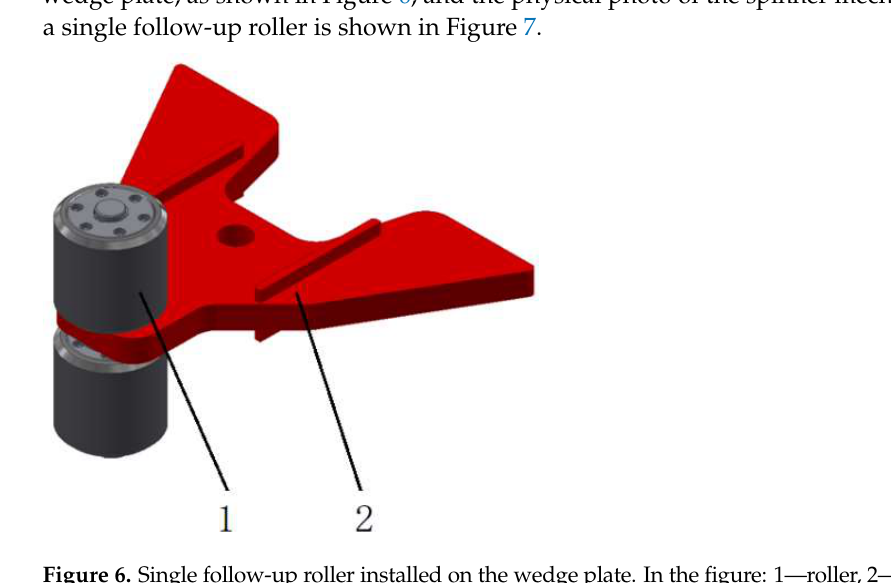
Figure 6. Single follow-up roller installed on the wedge plate. In the figure: 1—roller, 2—wedge plate.